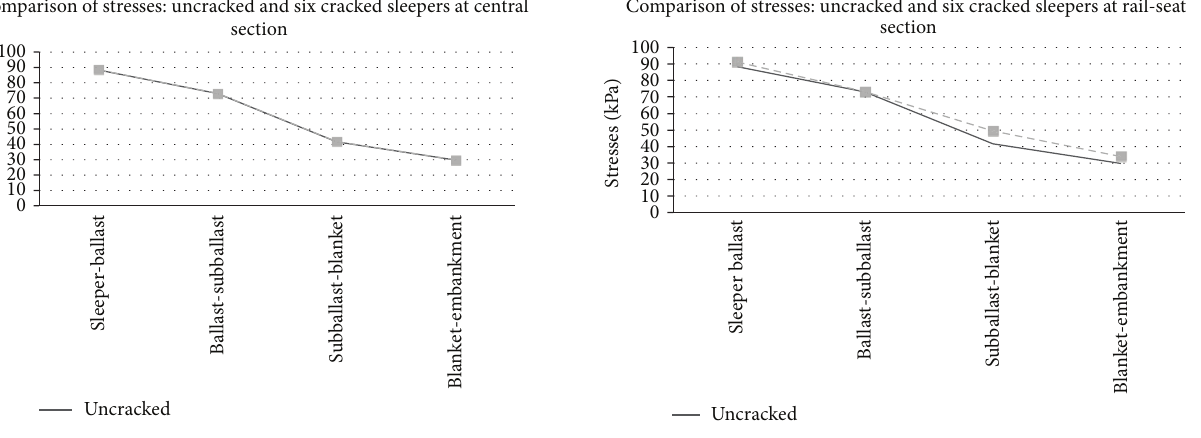
Figure 7: Comparison of stresses (KPa) in a track with healthy sleepers and six cracked sleepers at central section.